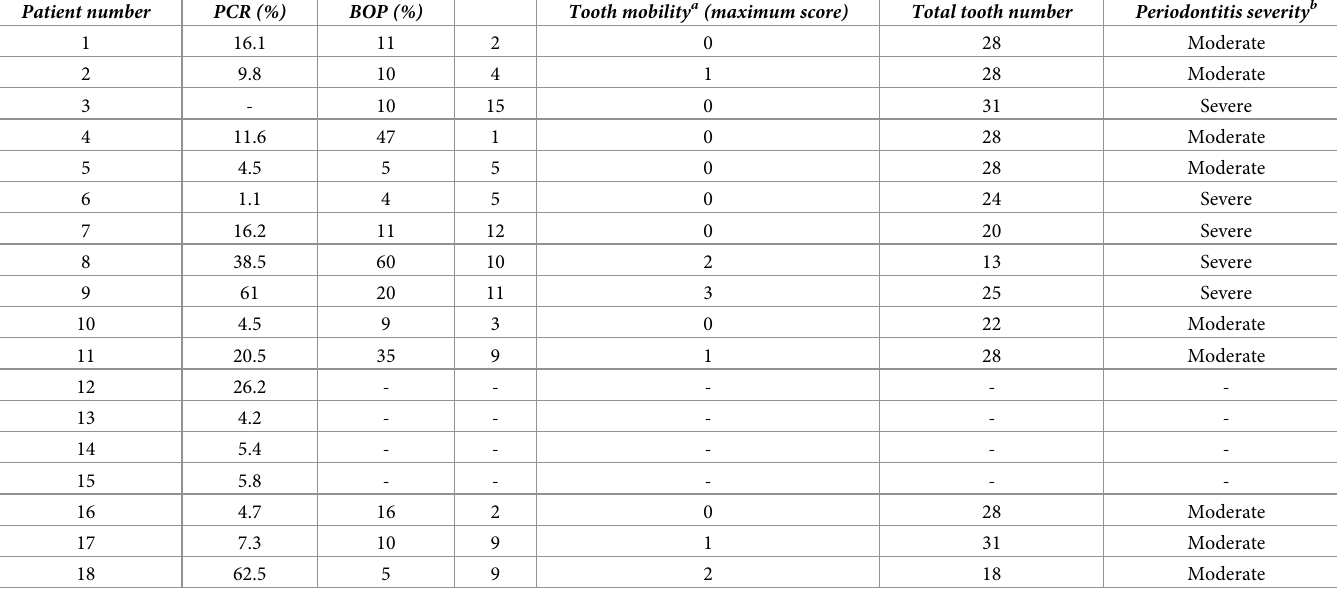
Table 2. Dental data of